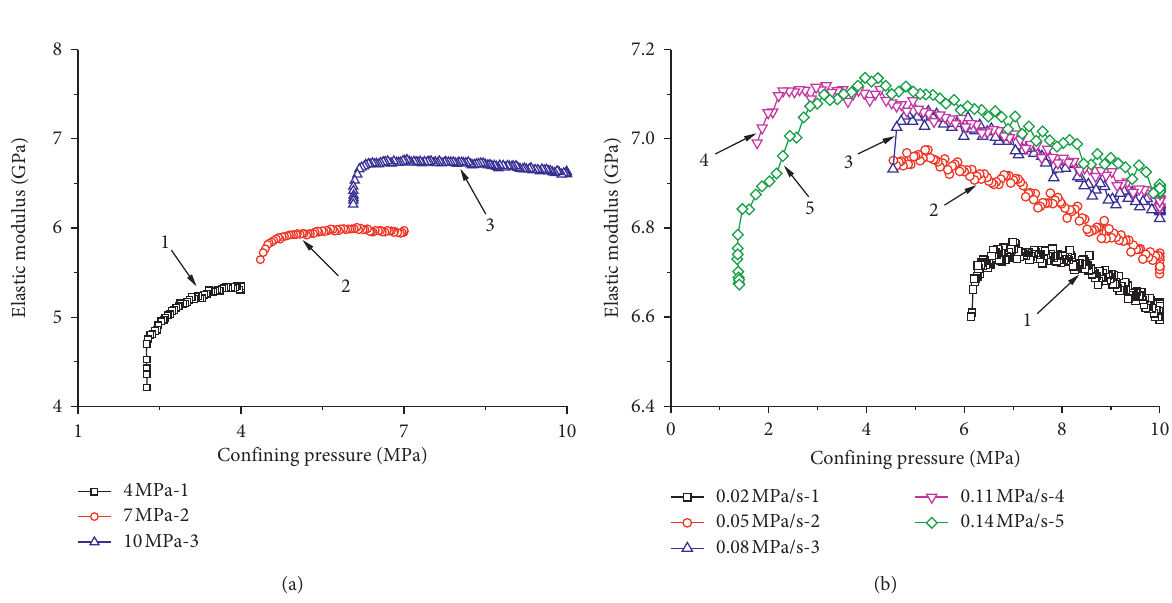
Figure 5: Elastic modulus under different test conditions. (a) Different confining pressures. (b) Different confining pressure unloading rates.